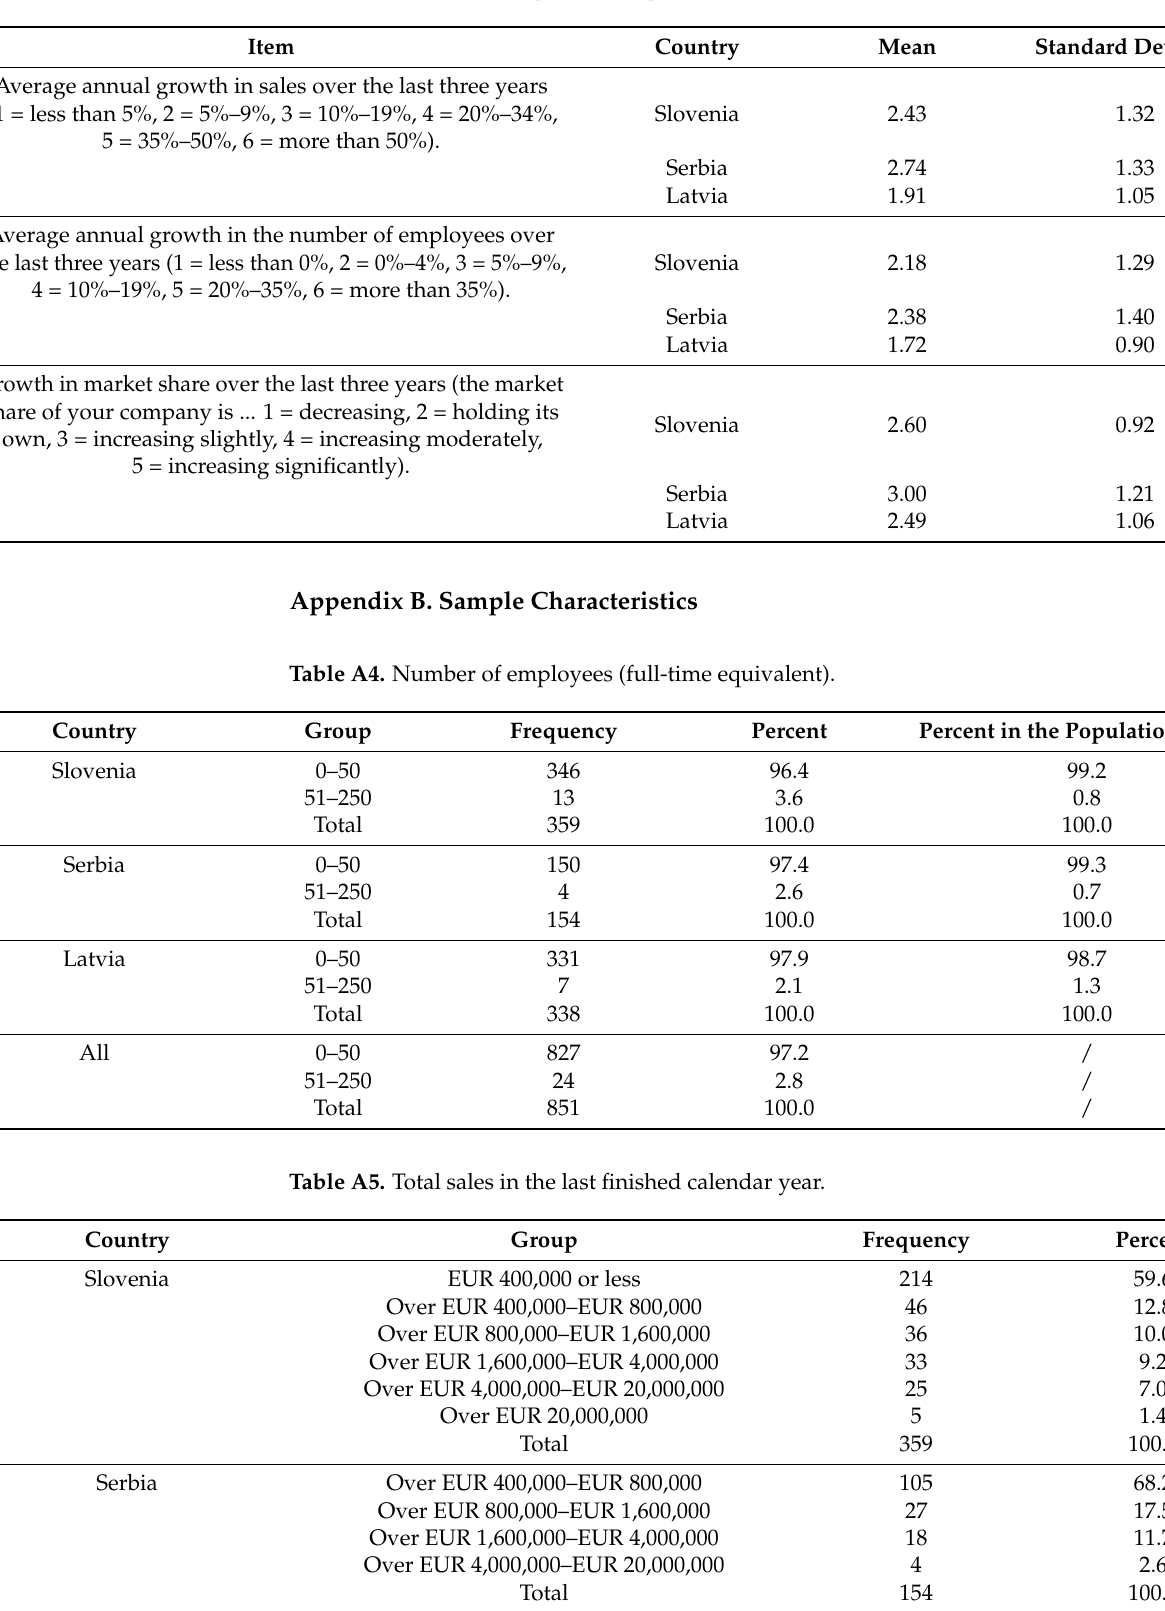
Table A3. Growth items [14,80,83,84].